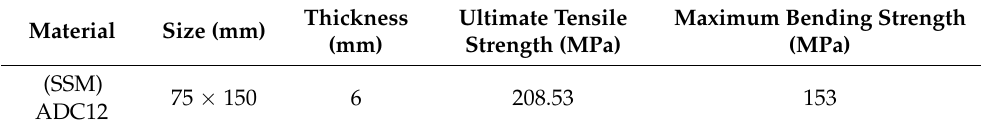
Table 6. Details of the tested